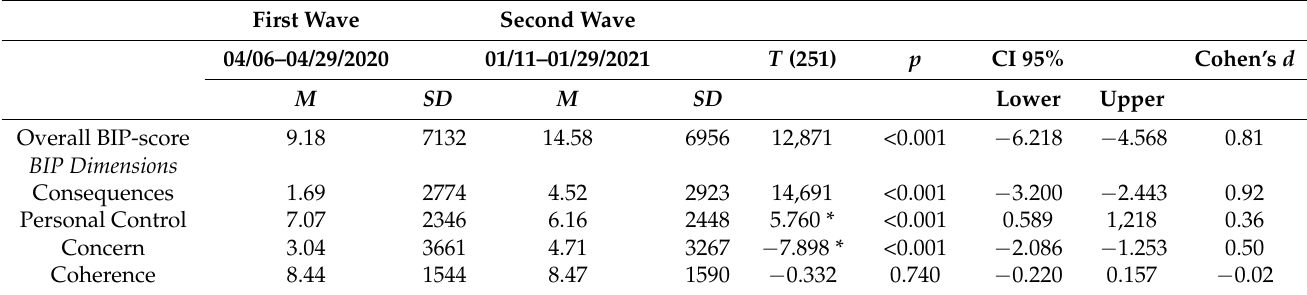
Table 3. Comparison of the BIP sum at the first (w1) and second (w2)